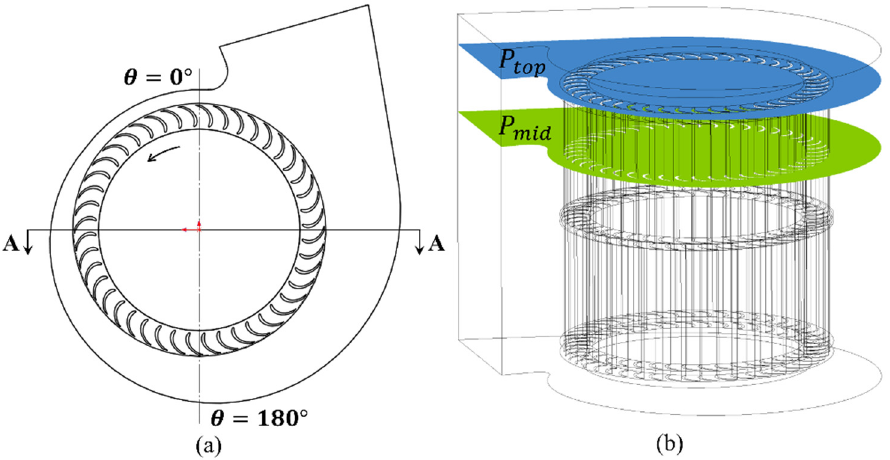
Figure 14. Observation section: ( a ) the section A–A and ( b ) the section P mid and P top